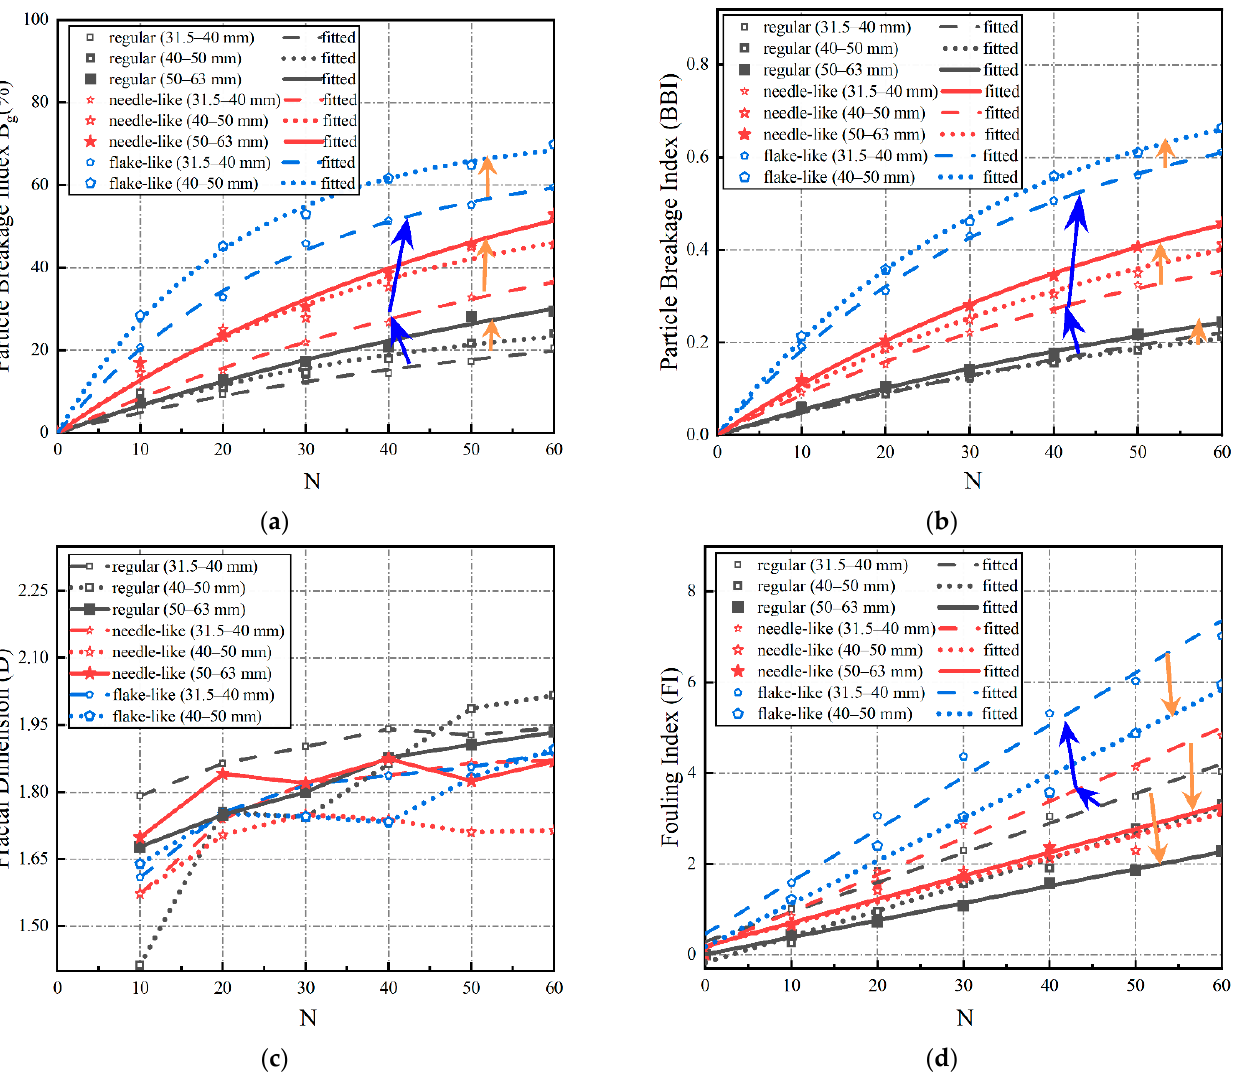
Figure 9. Evolution of four particle-breakage indices with the number of impact-load applications (N) for distinctly shaped single-size ballast specimens: ( a ) B g ; ( b ) BBI; ( c ) D; ( d ) modified FI. Table 3. The fitted coefficient values of Equations (7) and (9) for distinctly shaped single-size